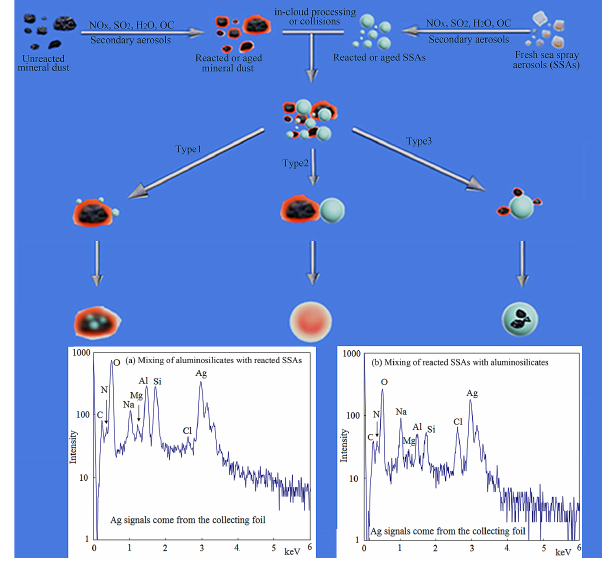
Fig. 13. Formation process of the coagulation of mineral dust with sea spray aerosols